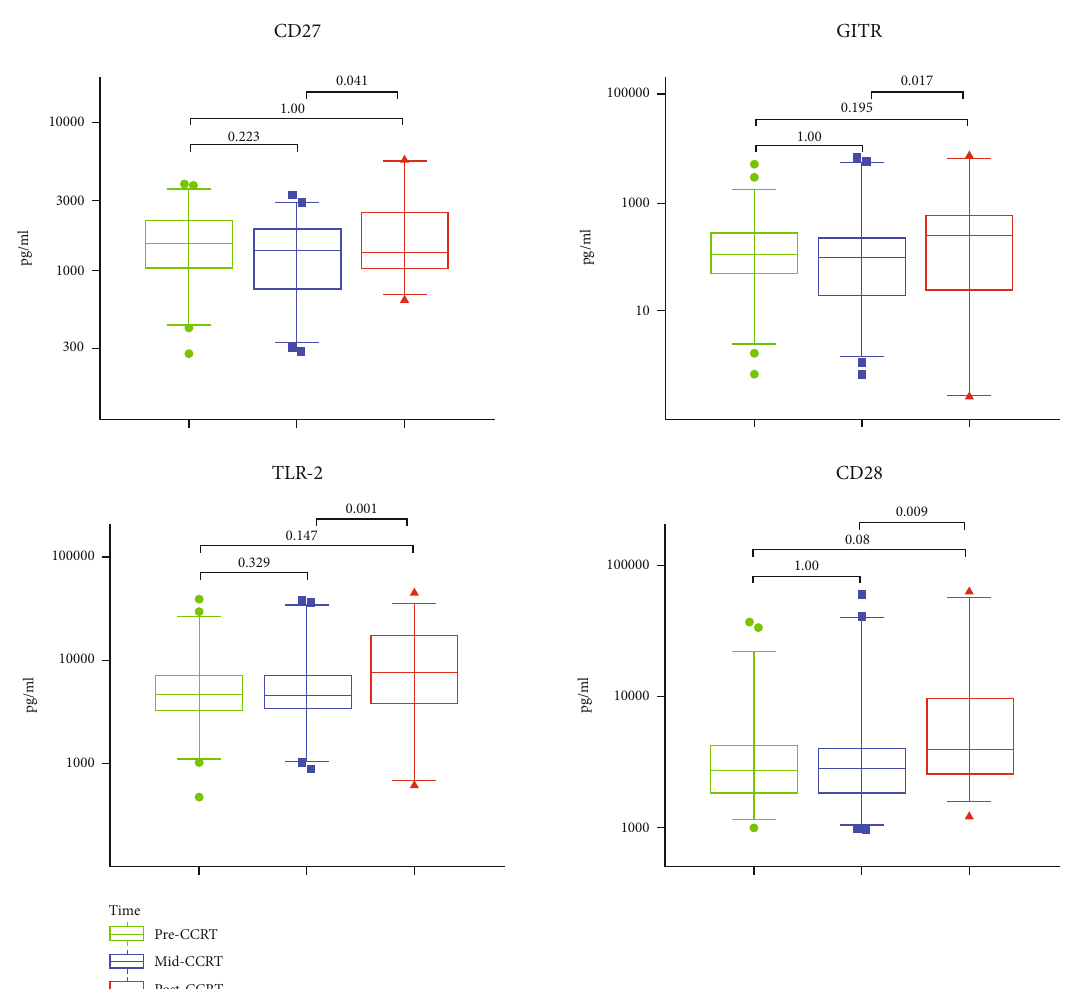
Figure 3: Slight changes in the levels of sICPs after CCRT. The serum levels of CD27, GITR, TLR-2, and CD28 were compared among pre- CCRT (green), mid-CCRT (blue), and post-CCRT (red), showing slight changes after CCRT. No signi fi cant di ff erence was found in the levels between pre-CCRT and post-CCRT. The P values were calculated using the Friedman test with Bonferroni ’ s